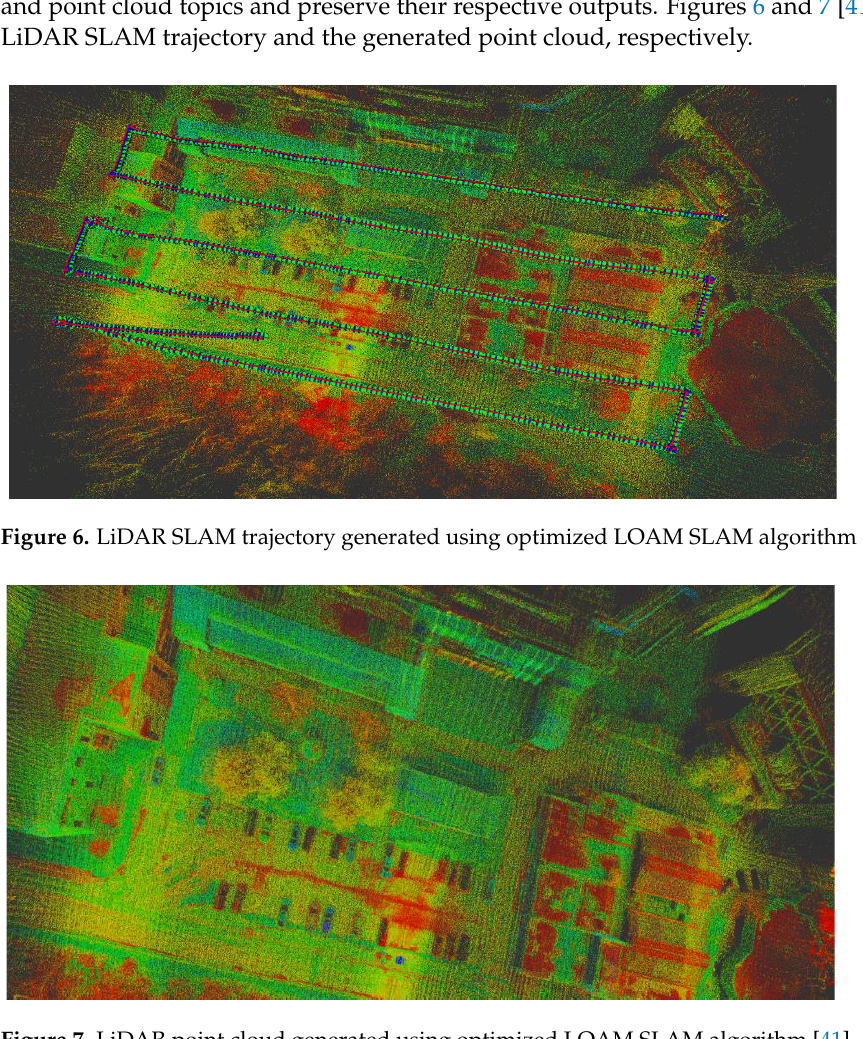
Figure 7. LiDAR point cloud generated using optimized LOAM SLAM algorithm